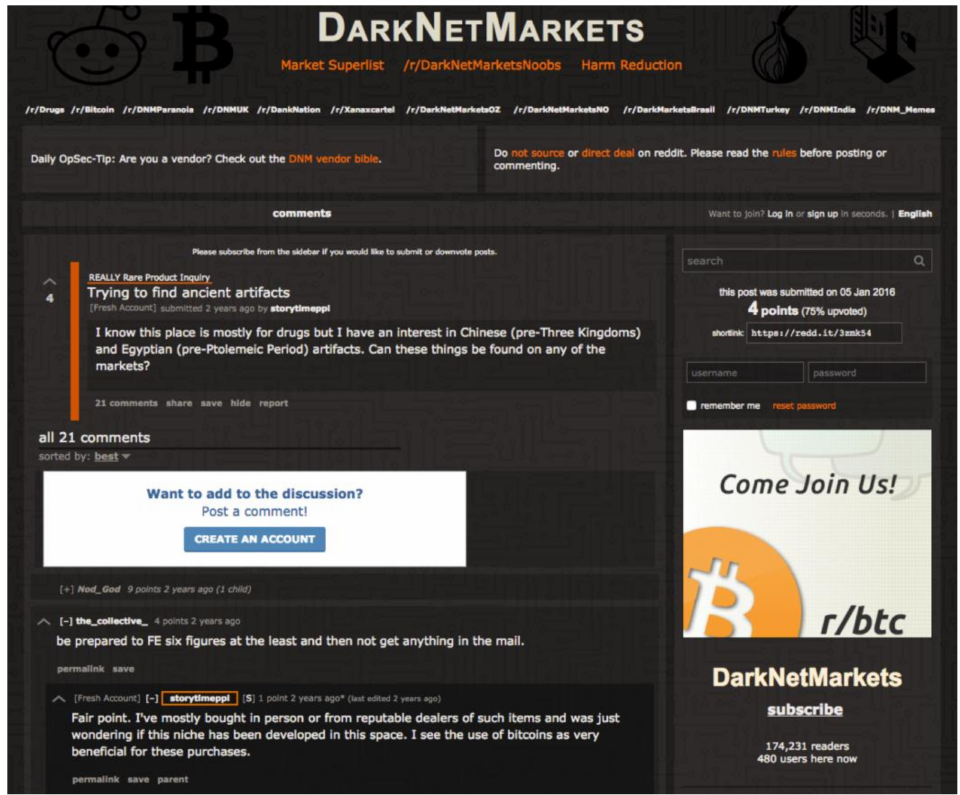
Figure 8. Screen grab of the subreddit for Dark Net Markets (r/DarkNetMarkets) with a specific request for Egyptian and Chinese antiquities. (Screen grab by author 2018).